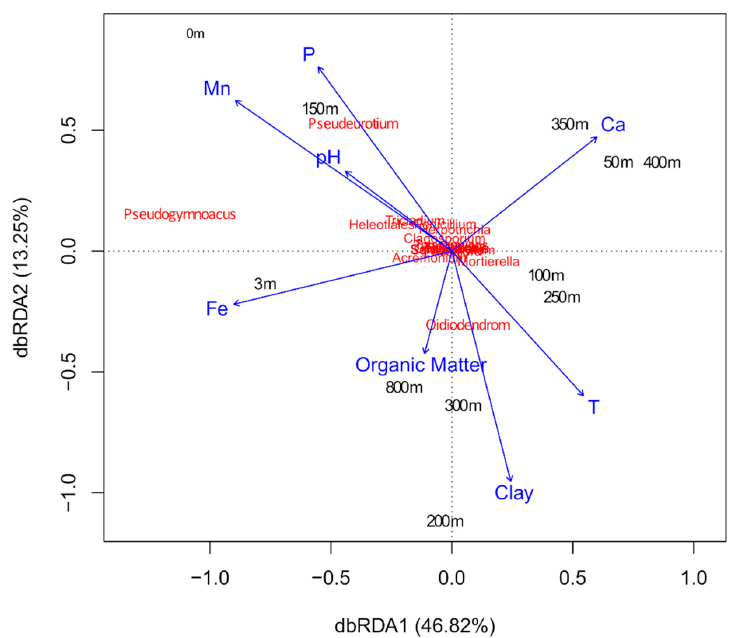
Figure 4. Distance-based redundancy analysis (dbRDA) ordination based on the weighted Sorensen distance with plotting of the environmental parameters and the fungal community at each collection point.